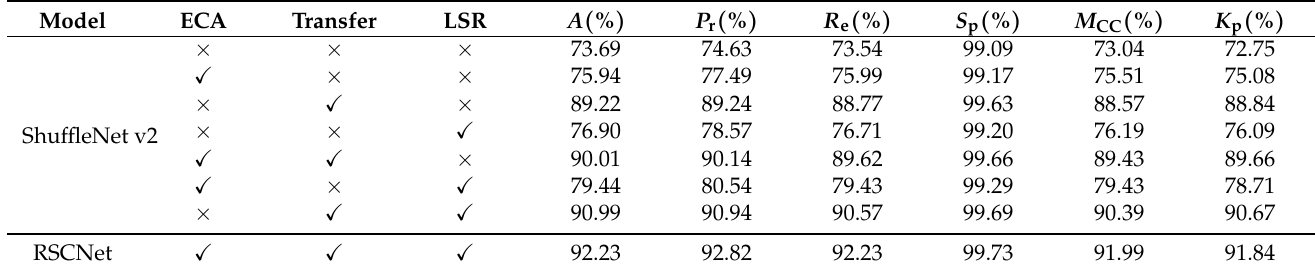
Table 5. Test results of the proposed method on the AID dataset. The training data ratio is 0.1.